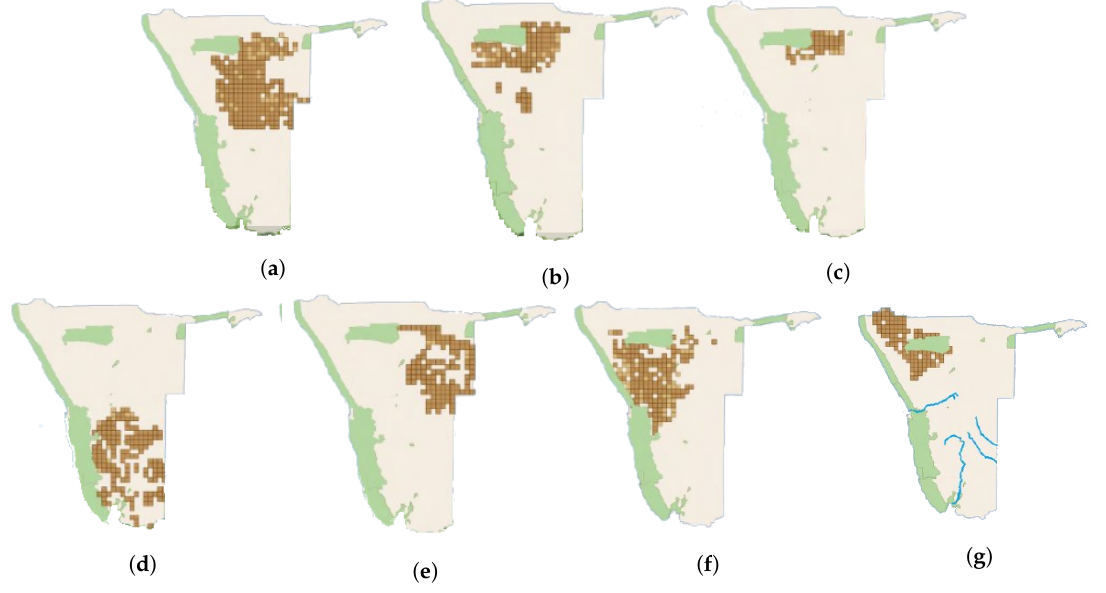
Figure 3. Distribution of encroacher bush occurrence by species: ( a ) Senegalia mellifera , ( b ) Dichrostachys cinerea , ( c ) Terminalia prunioides , ( d ) Rhigozum trichotomum , ( e ) Terminalia sericea , ( f ) Vachellia reficiens , and ( g ) Colophospermum mopane &Prosopis [22]. Green represents areas of encroacher bush